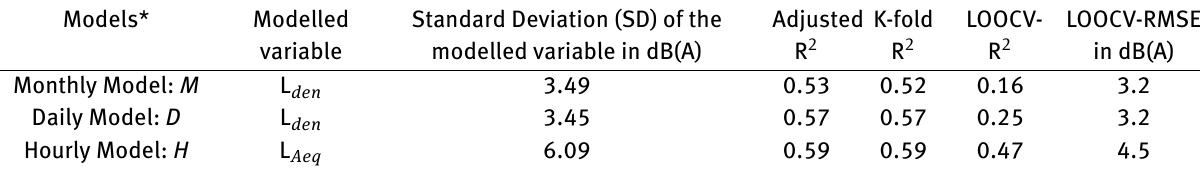
Table 4: Validation result of the models